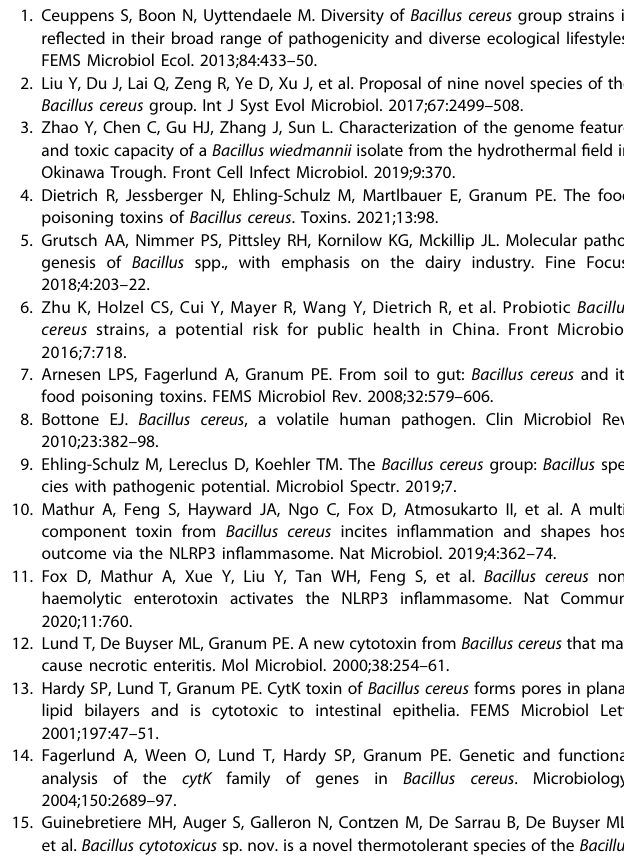
DATA AVAILABILITY All data generated or analyzed during this study are included in the article and its Supplementary Information fi les.